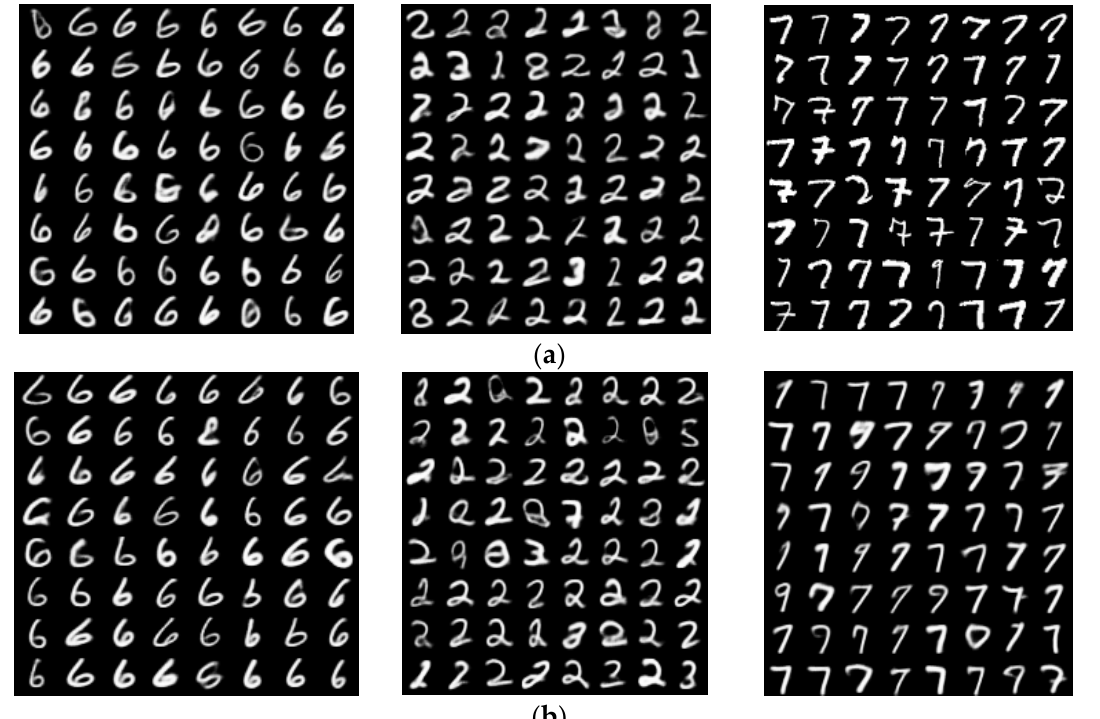
Figure 12. ( a ) Sampled datasets of “6, 2, 7” ingested into the VAE model; ( b ) Output datasets obtained from the VAE model.